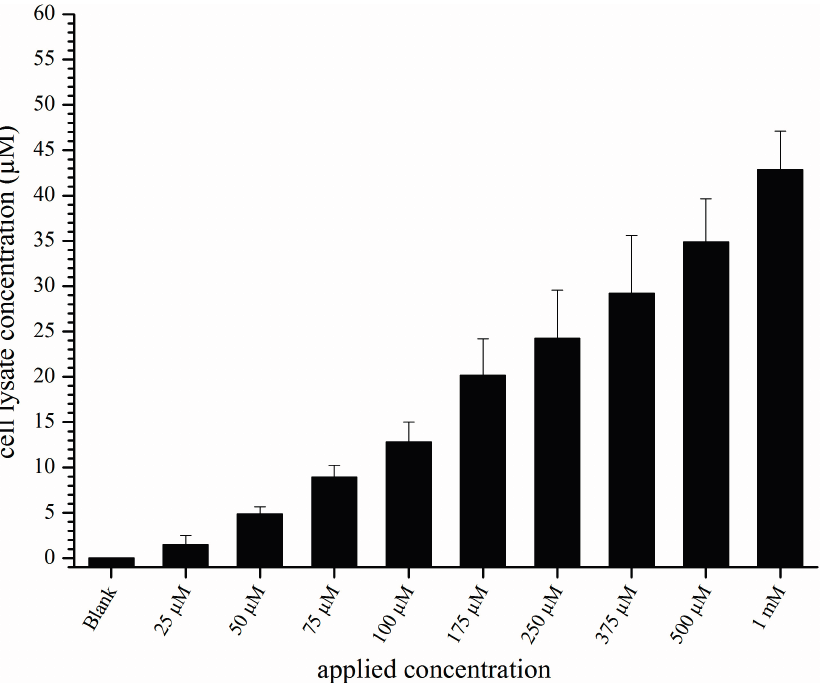
Figure 1. Liposomal concentration in cell lysate after incubation with cationized bovine serum albumin (cBSA)-liposomes for 2 h. Values are the means of 3 separate experiments ± standard deviation ( n = 8, each).